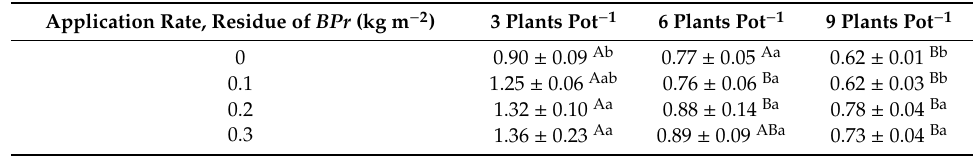
Table 2. The shoot to root ratio of CR growing in pot treated with the residue of BPr at four di ff erent application